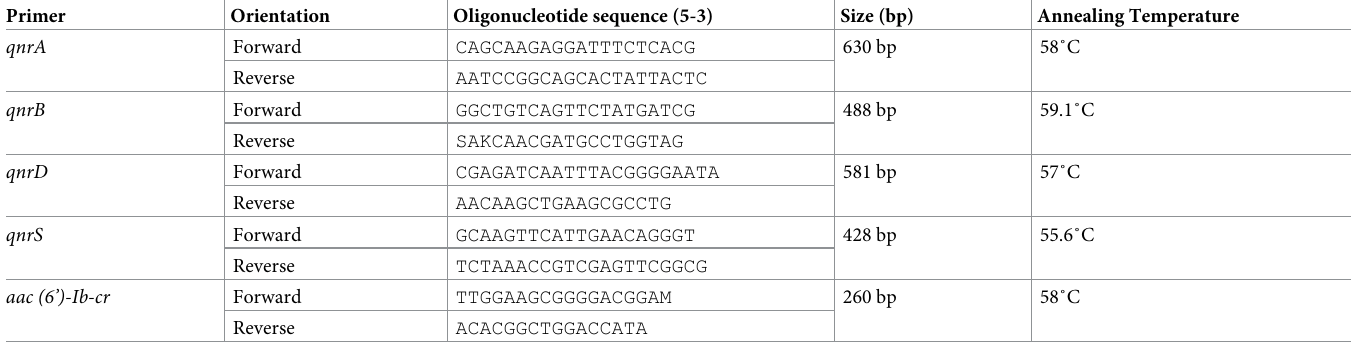
Table 2. Primers for polymerase chain reaction of PMQR